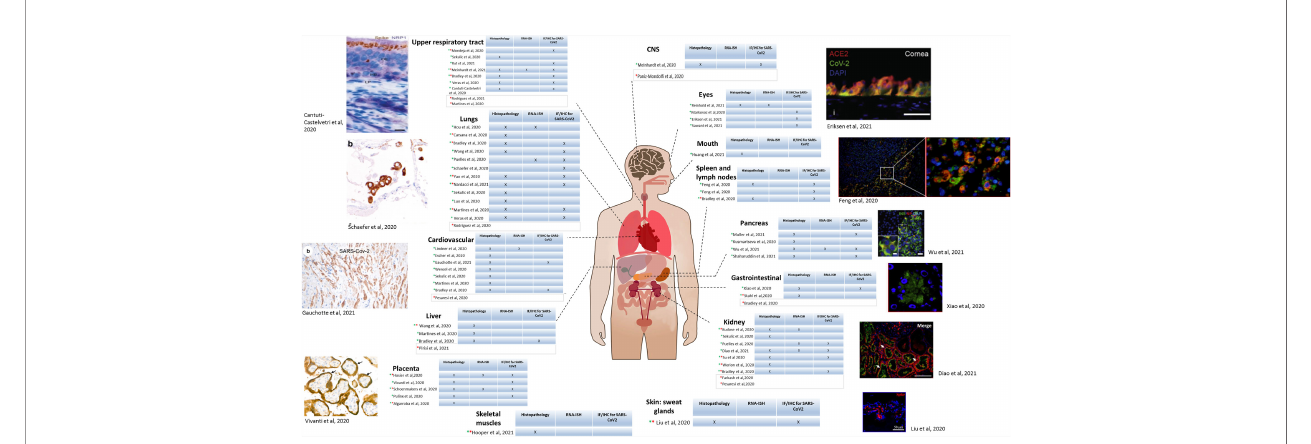
FIGURE 3 | SARS-CoV-2 tropism in patients determined by microscopy. Diagram of the human body depicting each organ in which SARS-CoV-2 has been detected in biopsies from patients. For each organ, a table is included indicating the method used for detection. Column 1: histopathology; Column 2: RNA in situ immunohistochemistry (RNA-ISH),; Column 3: Immuno fl uorescence (IF) and/or Immunohistochemistry (IHC). Green star indicates light microscopy performed, and red star electron microscopy. For the studies having light microscopy done, an example of microscopic image is included. Upper respiratory tract: Apical olfactory epithelium (OE) of a COVID-19 patient; LP, lamina propria; HB, horizontal basal cells. Brown: spike protein; blue: NRP1 (Cantuti-Castelvetri et al., 2020) Lungs: IHC on lung sections showing SARS-CoV-2 positivity in pneumocytes. Co-staining showing co-localization of TTF-1 (brown)/SARS NC (red). (Schaefer et al., 2020) Cardiovascular: Staining of cardiomyocytes, NC protein. (ICC/X200). (Gauchotte et al., 2021) Placenta: Transplacental transmission of SARS-CoV-2 infection. Immunostaining for SARS-CoV-2 protein (X800) showing brown staining of peri-villous trophoblastic cells. (Vivanti et al., 2020) Eyes: Immunostaining of post-mortem human ocular surface tissue (limbal region). Green: SARS-CoV-2 spike protein, Red: ACE2 receptor. Blue: DAPI. (Eriksen et al., 2021) Spleen and lymph nodes: Immuno fl uorescence of spleen and lymph node tissue for SARS-CoV-2 NP (green); red: CD169 marker, blue: DAPI. Scale bar: 100 m M. (Feng et al., 2020a) Pancreas: Staining of pancreatic islets from COVID-19 patients. Red: SARS-CoV-2 NP. Green: insulin. (Diao et al., 2021) Scale bar: 5 µm. (Wu et al., 2021a) Gastrointestinal tract: Immuno fl uorescent staining of stomach tissues. Green: NP, blue: DAPI Scale bar: 20 m m. (Xiao et al., 2020) Kidney: kidney sections from COVID-19 post-mortem. Green: ACE2; Red: Spike protein; blue: Dapi. Arrows: positive tubules. Scale bars: 100 m m Skin: Immuno fl uorescence analysis in sweat glands infected by SARS-CoV-2 from deceased donors. Red: spike protein, blue: DAPI. Scale bar: 50 µm. (Liu et al., 2020a) Upper respiratory tract: (Bradley et